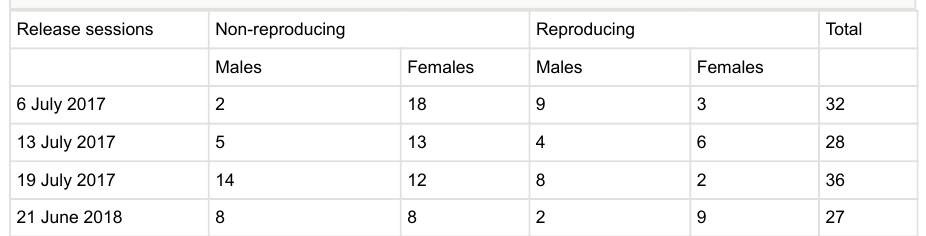
Sex and age of the translocated individuals throughout the three years of the population reinforcement action. Non-reproducing includes juveniles and